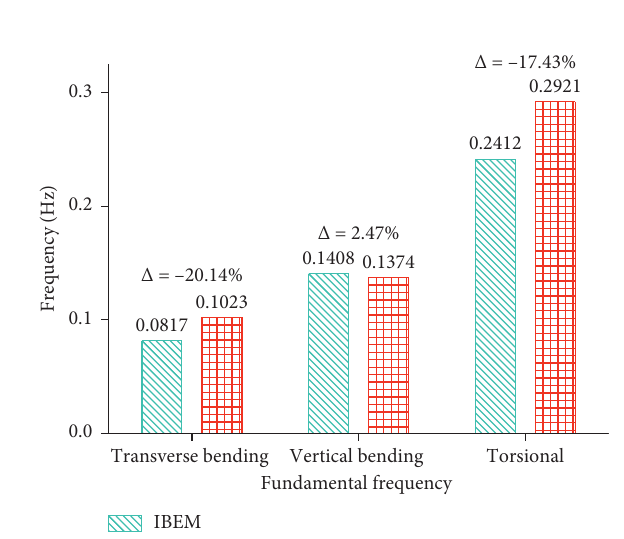
Figure 5: Girder quality comparison diagram.